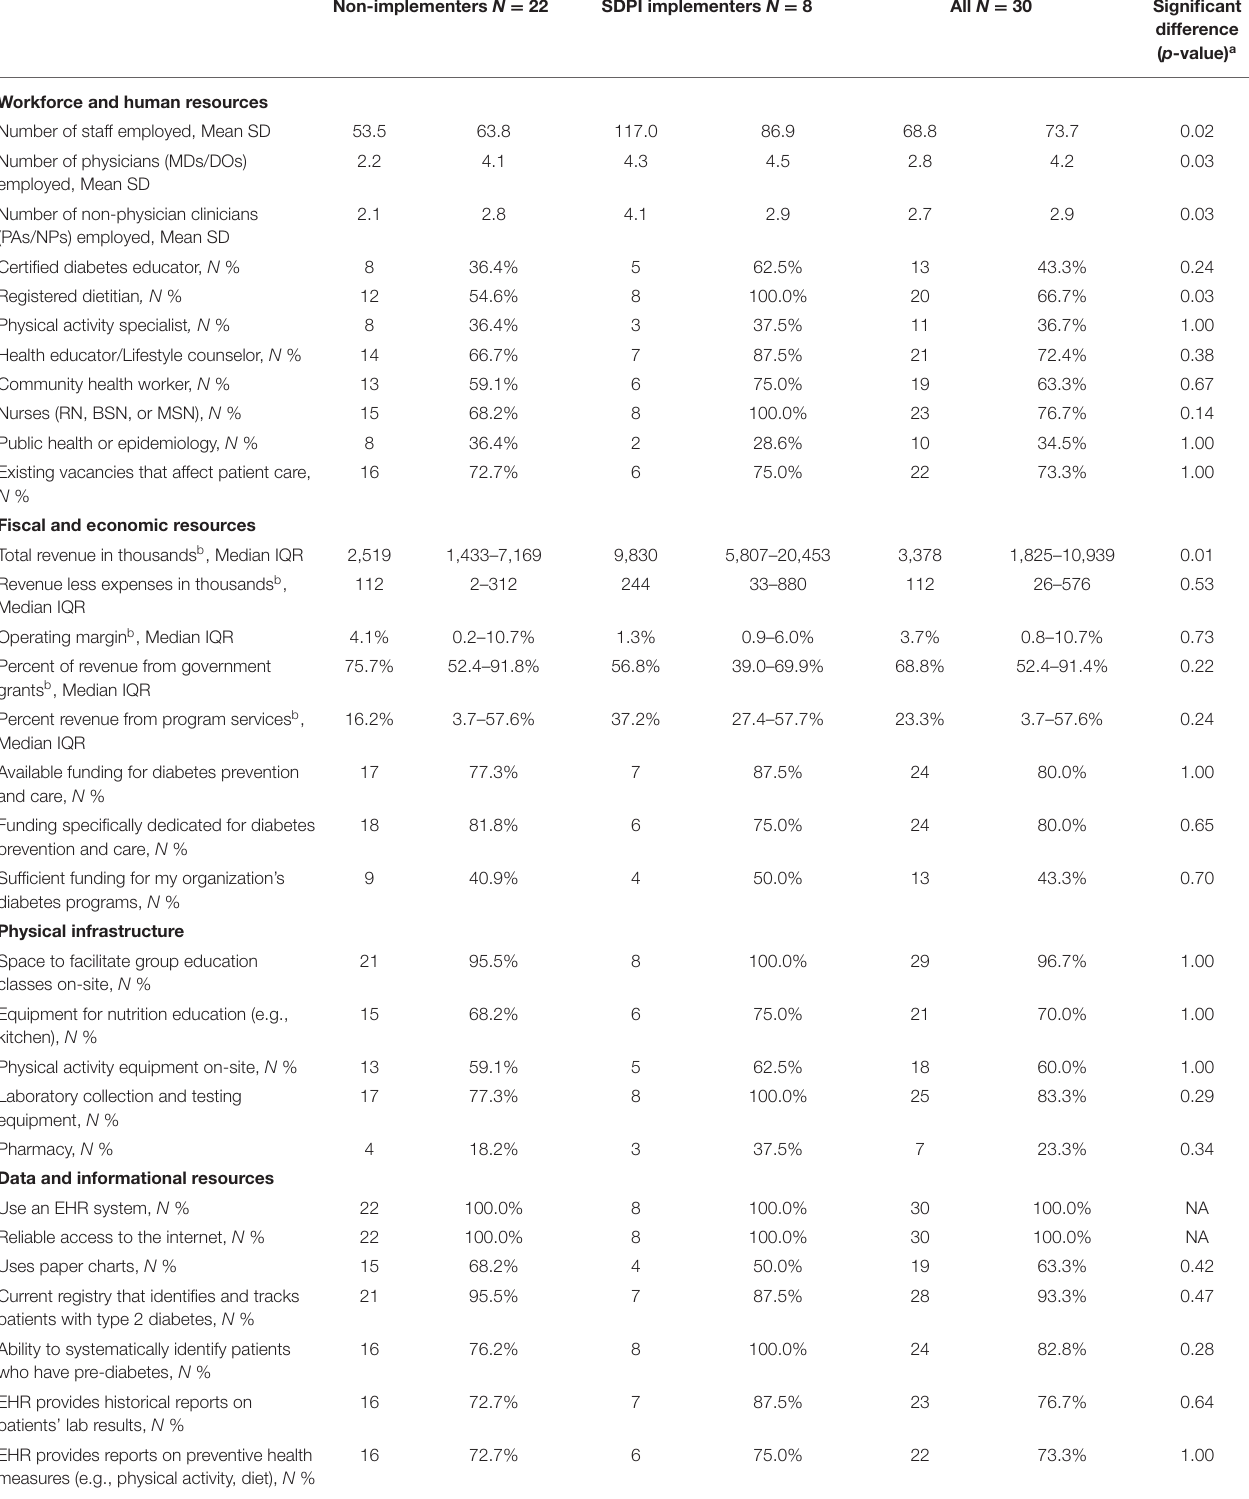
TABLE 2 | Comparison of implementers vs. non-implementers by organizational capacity domain. Non-implementers N = 22 SDPI implementers N = 8 All N = 30 Significant